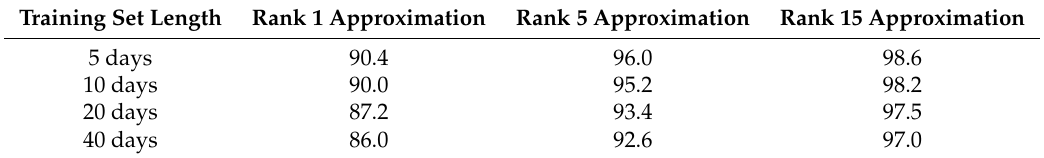
Table 4. Each cell denotes the percentage of variation captured by the corresponding low rank approximation and training set. These results are specific to the times and the weather stations used and provide general guidance on the trade off between dimension reduction and information